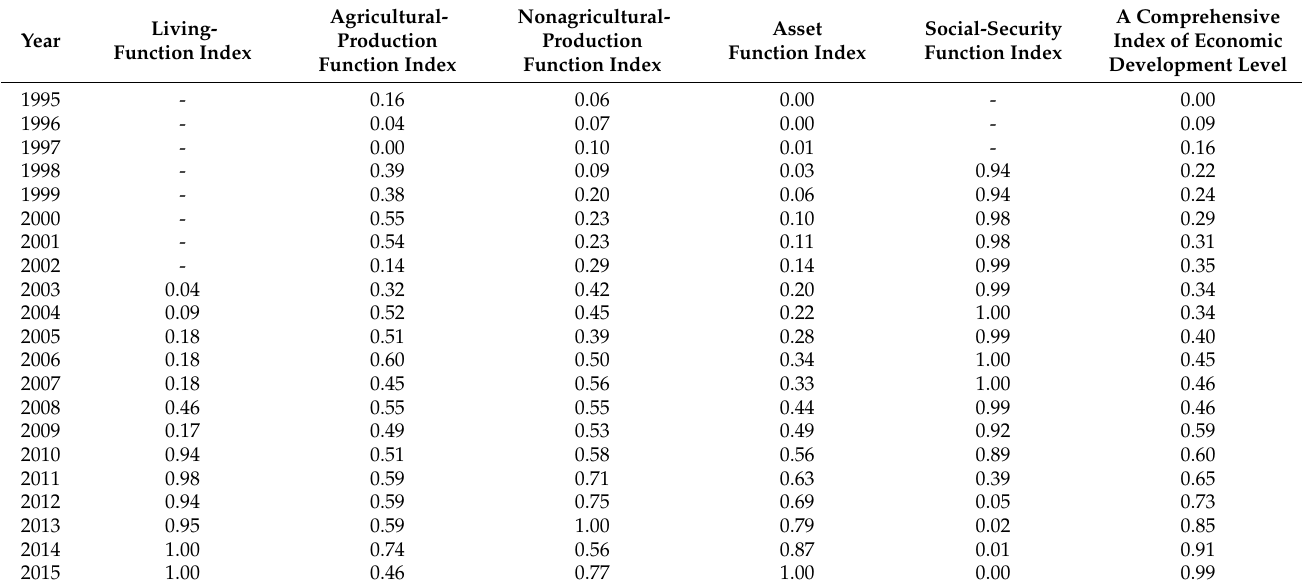
Table 2. Comprehensive evaluation results of rural-homestead functions and economic develop- ment level.